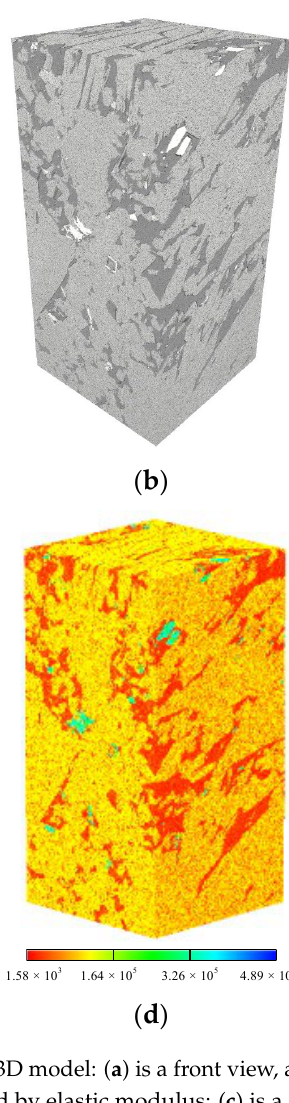
Table 1. Material properties of the shale FE model